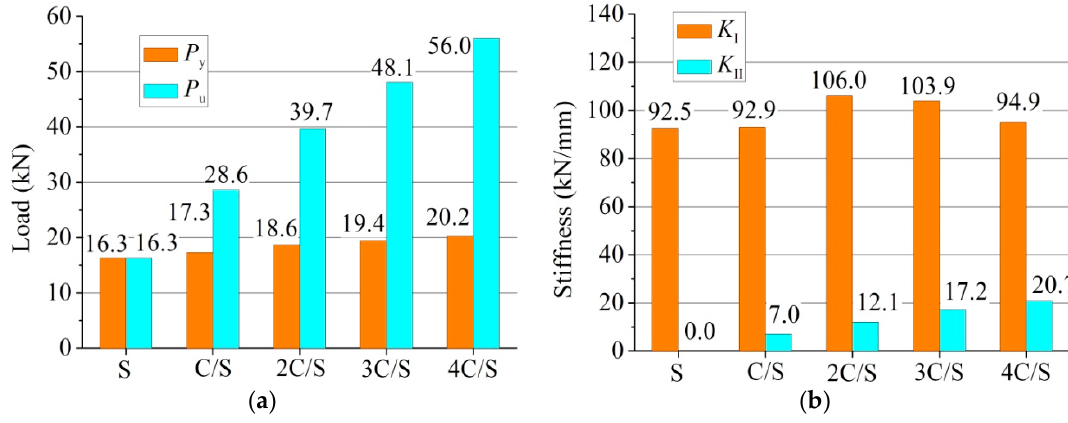
Figure 7. Effects of the number of CFRP layers: ( a ) yield and ultimate load of specimens; and ( b ) elastic and post-elastic stiffness of specimens.